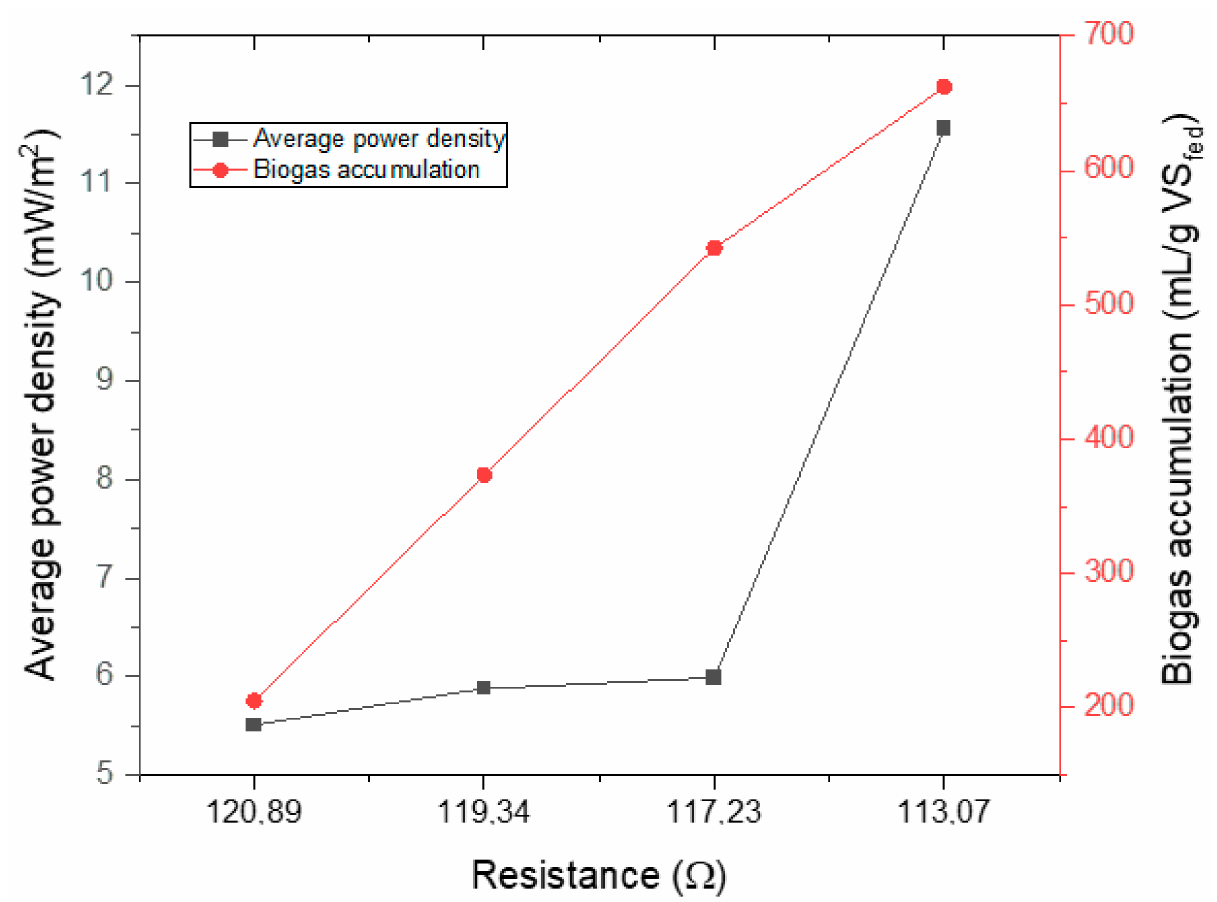
Figure 6. Average power density and biogas accumulation with respect to